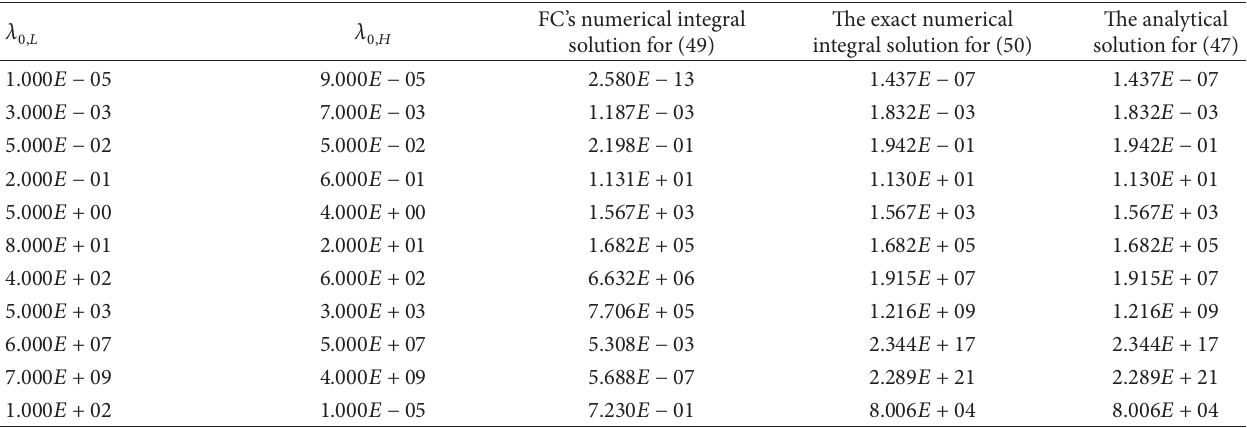
Table 3: Comparison of different solutions for 𝑚 = 4 in the case of 𝜆 0,𝐿 + 𝜆 0,𝐻 ̸= 1 . 𝜆 0,𝐻